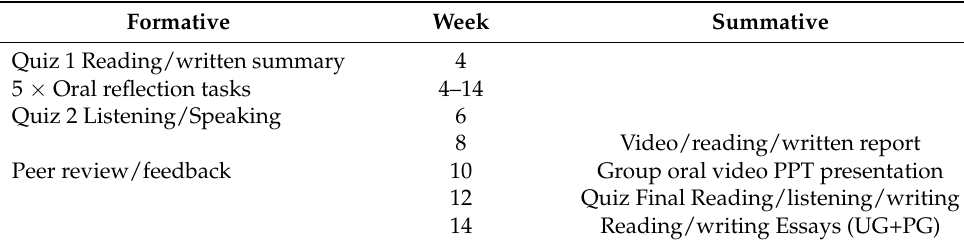
Table 1. Task distribution over 12-week